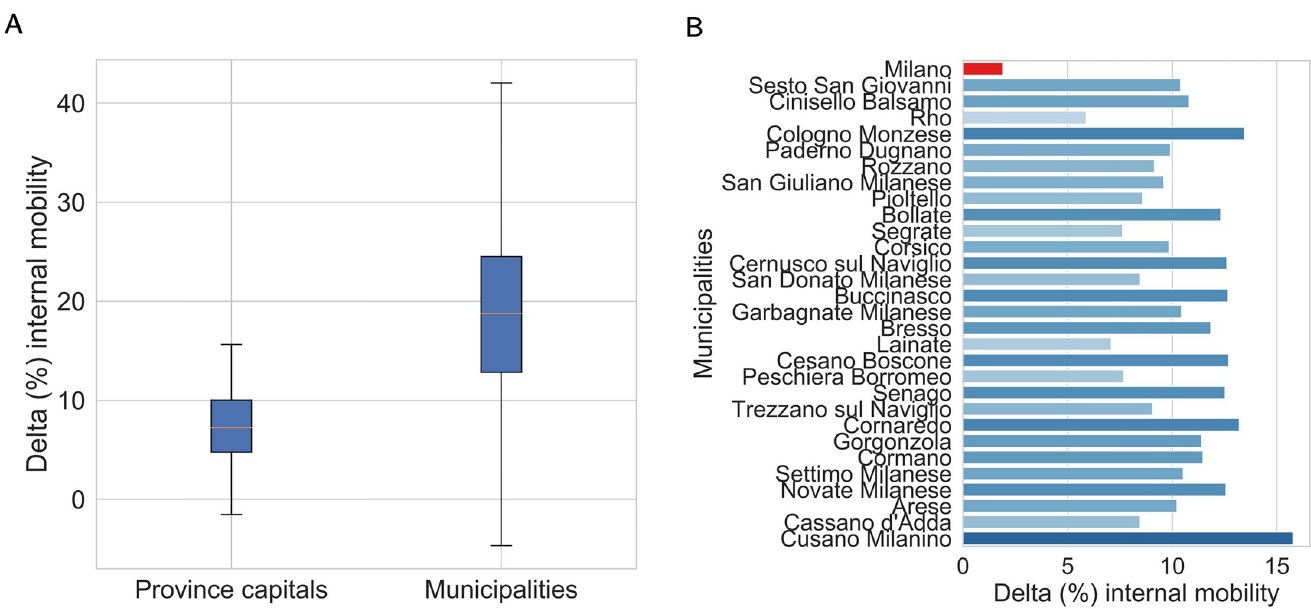
Fig 3. Percentage variation of internal mobility for municipalities between the periods during and before lockdown. (A) compares the distribution for municipalities and province capitals in the entire peninsula, whereas (B) shows a detailed overview on Milan province and its